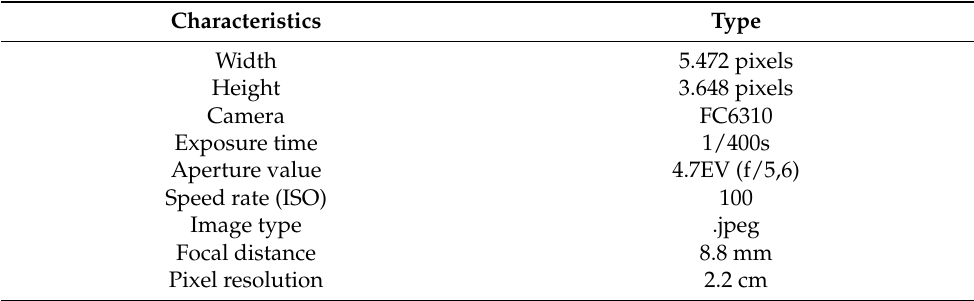
Table 1. Characteristics of images obtained from the UAV DJI PHANTOM 4